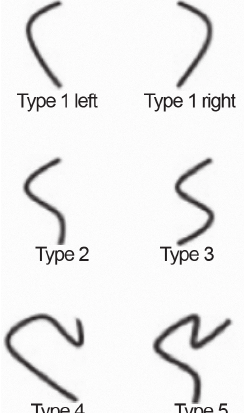
Figure 3. Schematic intestine forms observed in Potamolithus species from Alto Ribeira karst area, South- eastern Brazil. Abapertural